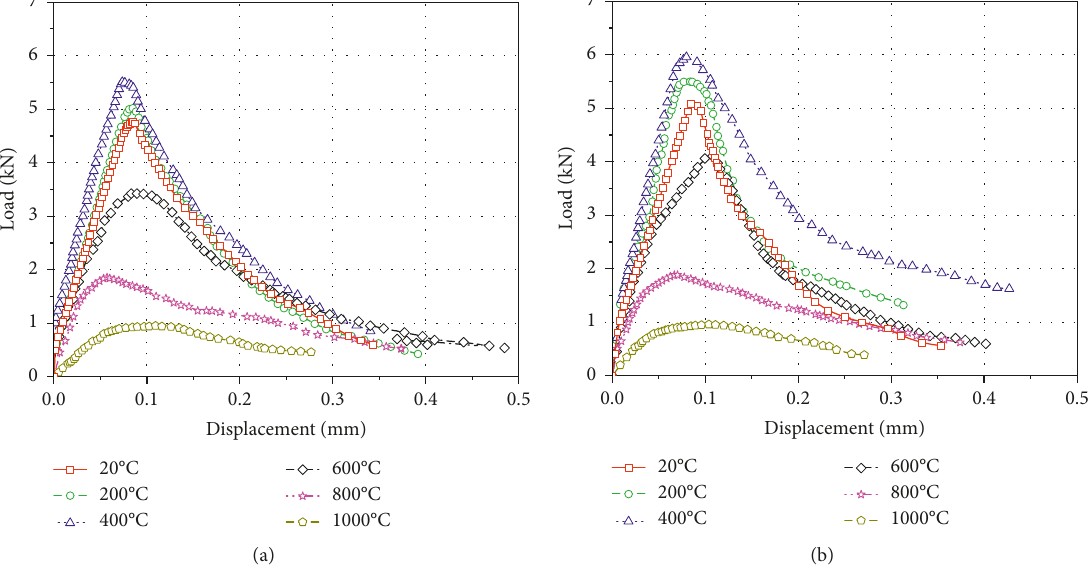
Figure 5: Load-deflection curves of (a) C0 and (b) C10F30 before and after exposure to various